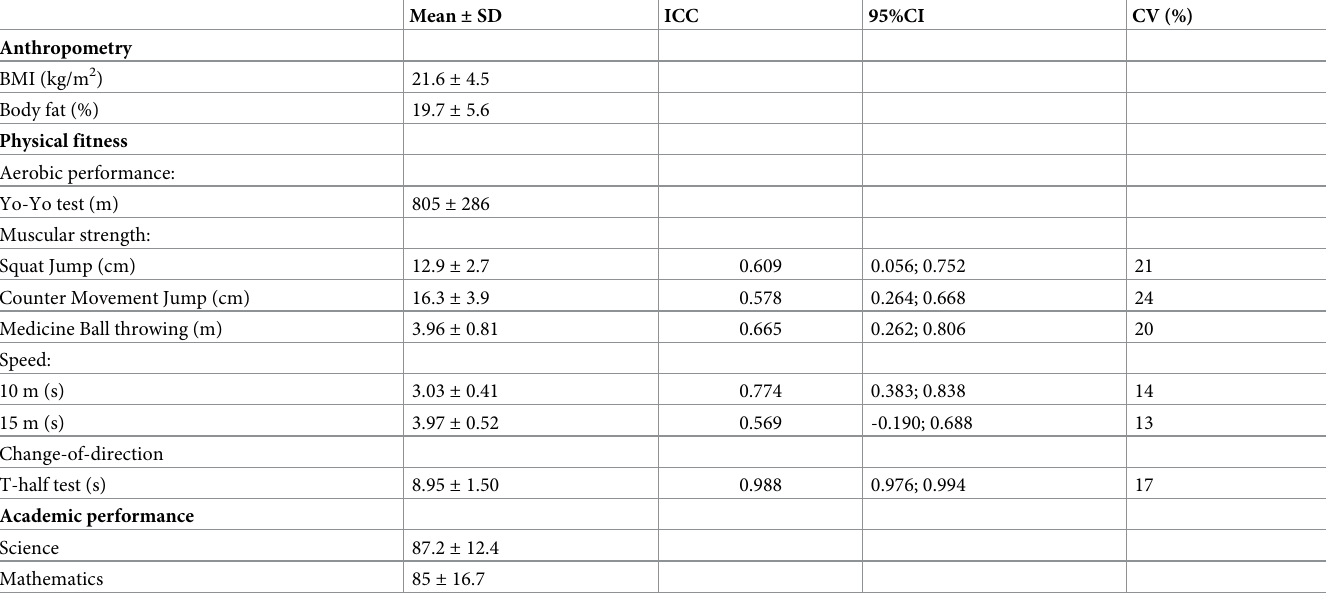
Table 1. Physical performance, academic achievement scores, Inter-class Correlation Coefficient (ICC) (ICC, 95% confidence limits) and Coefficient of Variation (CV) of the experimental group (n = 36). Mean ± SD ICC